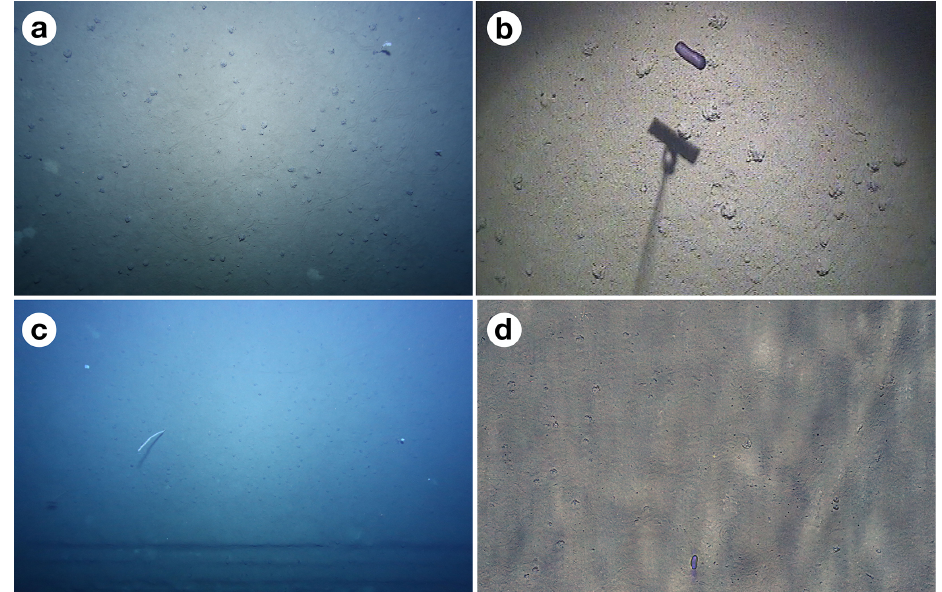
Figure 5. Example images of datasets DS E –DS H , with platform information and mean image footprints as follows. (a) DS E – AUV – 52.9m 2 . (b) DS F – OFOS – 2.6m 2 . (c) DS G – AUV – 169.1m 2 . (d) DS H – AUV – 32.8m 2